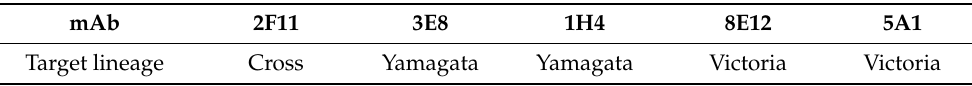
Table 2. Influenza B mAbs. Five mAbs used, two specific for each lineage of influenza B and one binding to an epitope conserved between both lineages